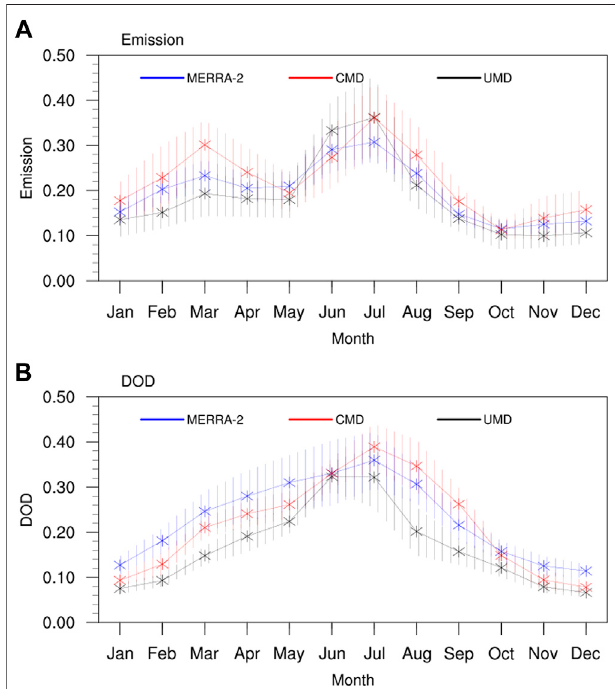
FIGURE 2 | Annual cycles of climatological averaged dust emission fl ux (A) and DOD (B) of west Asian deserts (WAD) obtained by MERRA-2 and simulations. The blue, red, and black lines represent MERRA-2, the CMD simulation,and theUMDsimulation,respectively.Verticallinesrepresent the standard deviation of DOD.